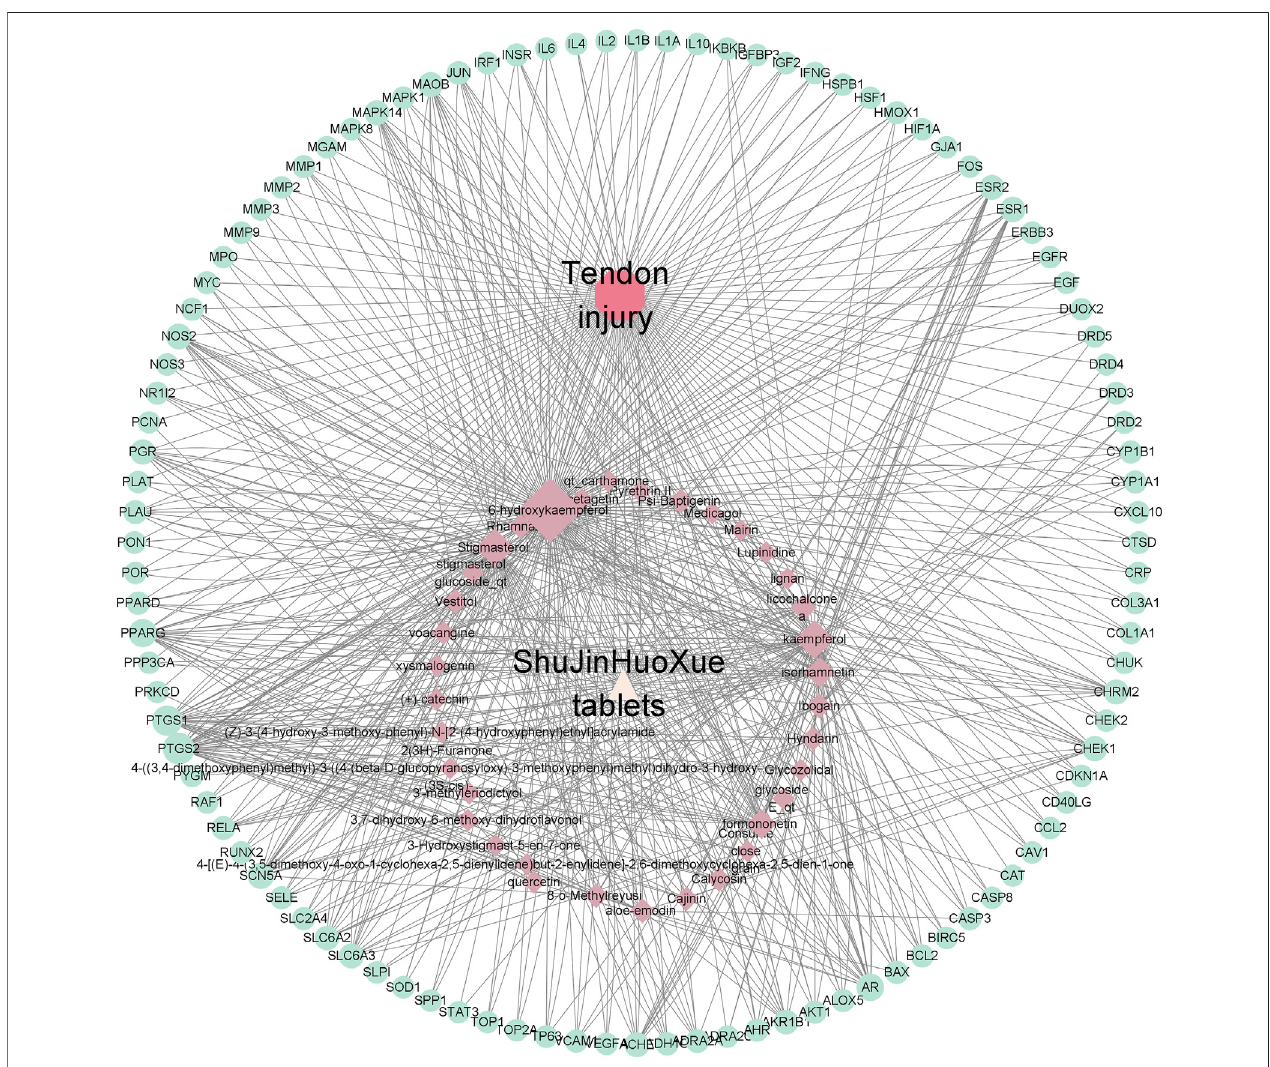
FIGURE 2 | Ingredient – target genes – pathway network of tendon